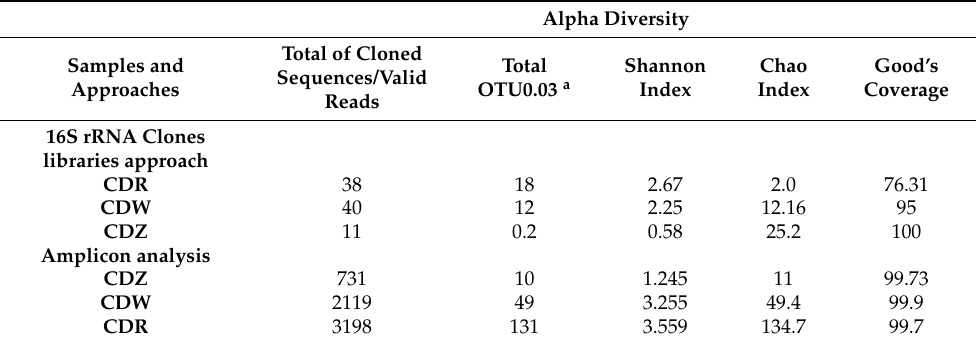
Alpha Diversity Total of Cloned Total Shannon Chao Good’s Sequences/Valid OTU0.03 a Index Index Coverage Reads